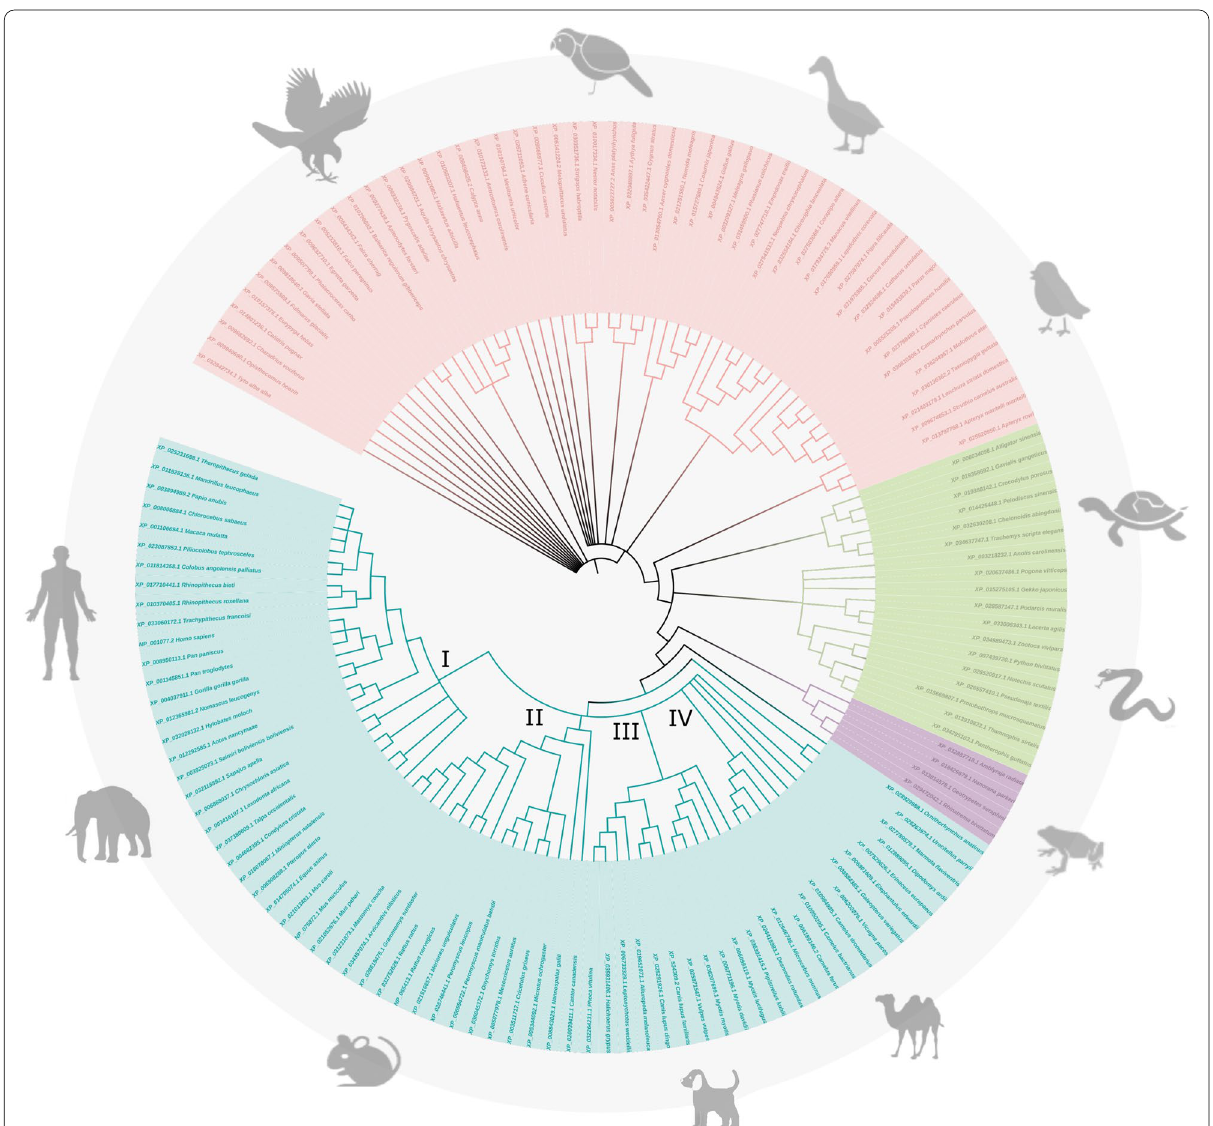
Fig. 1 Maximum Likelihood tree showing the phylogenetic relationships of AADAC orthologues. Mammal AADAC sequences are distributed in clades. Sequences from mammals are highlighted in blue, amphibians in lilac, reptiles in green, and birds in pink. Distances were calculated using the Jones‑Taylor‑Thornton matrix (JTT), and the tree was created with the Maximum Likelihood method with 1,000 bootstrap